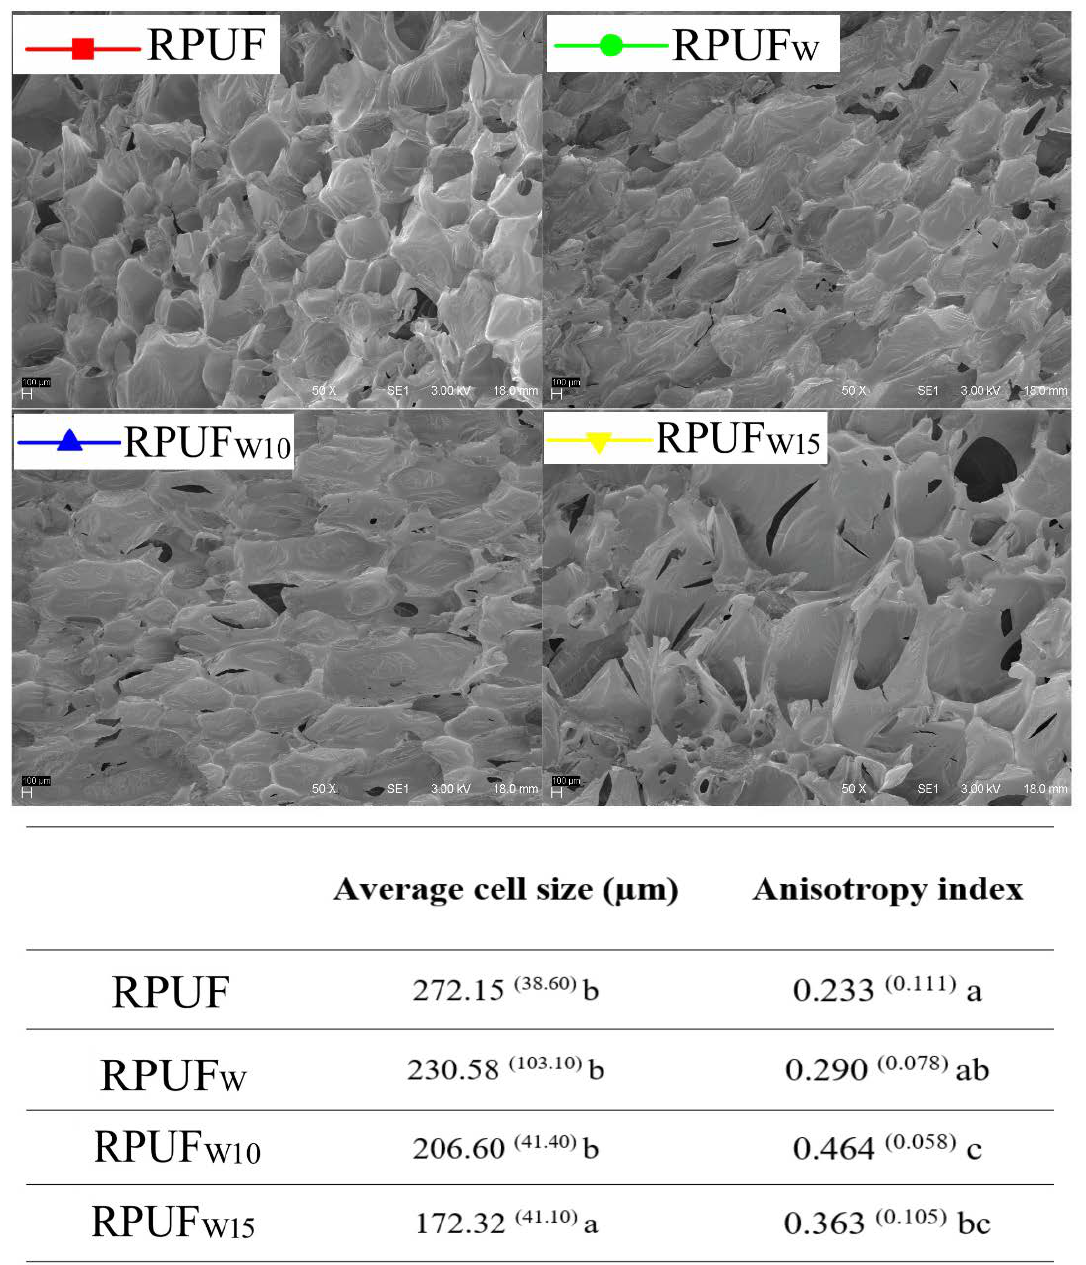
Figure 4. SEM images and morphological properties of the studied RPUFs. Different letters represent statistically different means. Different letters (e.g., a, b and c) represent statistically different means and equal letters represent no statistically different means (e.g., a and ab).